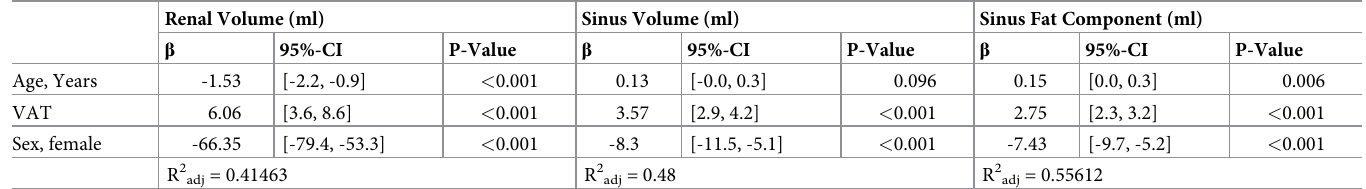
between obesity, hepatic function, insulin resistance and macro- as well as microangiopathy [9, 23]. It is thought to obstruct lymph and blood outflow of the kidney, leading to increasing organ size. A recent study has shown that in a metabolically benign condition, renal sinus fat reduces the release of (pro)-inflammatory factors. In a metabolically malignant condition fatty liver-derived hepatokines, such as Fetuin-A act on human renal sinus fat. Thus, the beneficial influence on glomerular cells is abolished, possibly leading to renal dysfunction and damage [12]. Previous studies have demonstrated the presence of interindividually varying amounts of fat around the vessels of the renal hilum in humans potentially influencing renal/glomerular function via organ crosstalk [8, 13]. cations and stage II hypertension [11] and is also thought to be an independent risk indicator of coronary artery calcification in middle-aged patients [37]. Our results corroborate with these findings, showing that individuals with prediabetes already show a considerable increase in renal sinus fat, whereas GFR remained almost constant. Renal sinus fat may also play an early role in the pathogenesis of exercise-induced albuminuria independently of sex, age, VAT and mean arterial peak pressure [13], so that it may serve as an early imaging biomarker for potential renal disease. Accordingly, in a large subcohort of the Framingham study, quantifica- tion of renal sinus fat accumulation was independently associated with both hypertension and chronic kidney disease [8]. In our study, there was a significant association between increasing Table 4. Regression model with adjustments for age, gender and VAT. Renal Volume